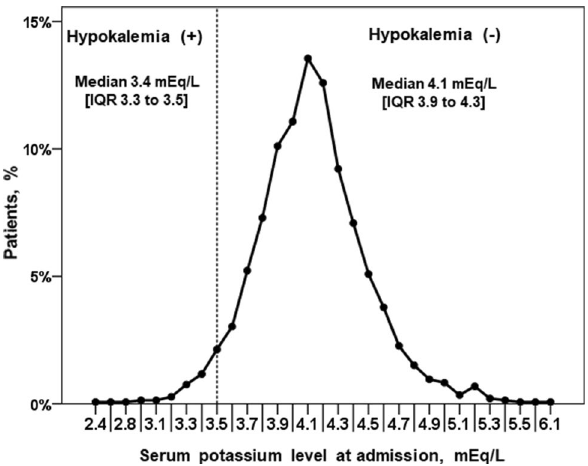
Figure 2. Distribution of serum potassium level at admission in the overall patient population.